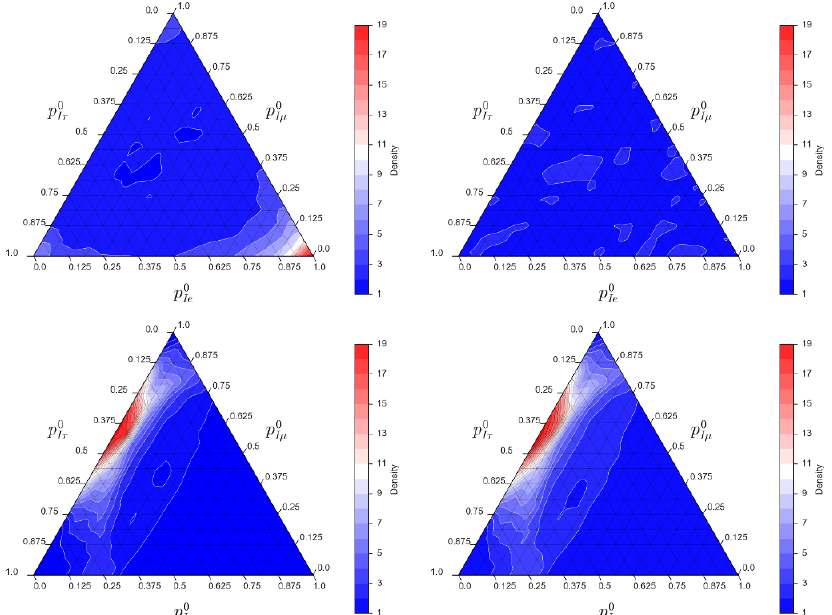
JHEP05(2019)011 Figure 2. Density distributions of (cid:13)avour probabilities p 0 obtained by a random generation of I(cid:11) U and (cid:10): in the top-left panel mixing angles have been generated randomly uniformly while in the top-right panel U and (cid:10) have been generated according to the Haar measure as explained in the body text. In the bottom panels the mixing angles have been generated Gaussianly using the experimental results still for a uniform generation of (cid:10) complex angles in the left panel or according to the Haar measure in the right